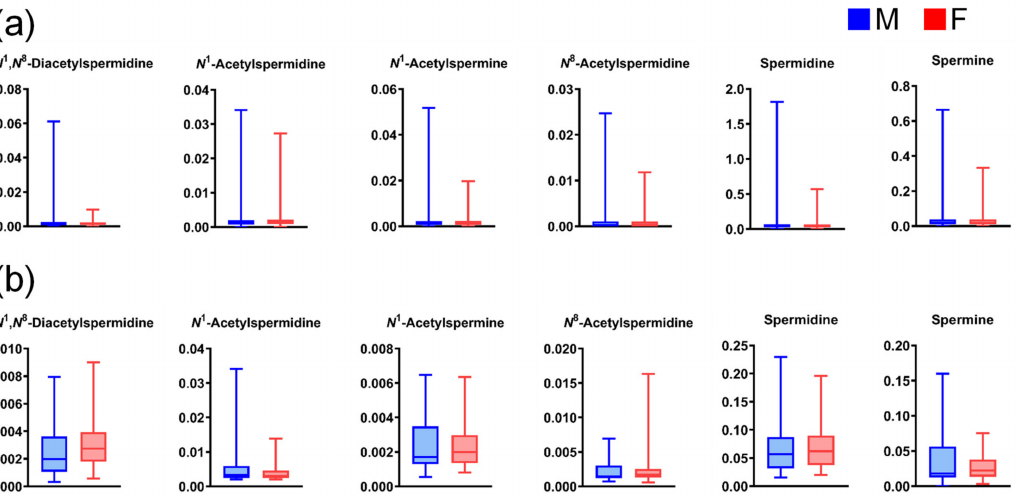
Figure A3. Differences in salivary polyamine concentrations between ( a ) healthy individual male (M) and female (F) participants ( n = 423 and 501, respectively) and ( b ) M and F patients with pancreatic diseases ( n = 27 and 40, respectively). Horizontal lines of box plots present 0, 25, 50, 75, and 100% of data. All comparisons show p > 0.05, using the Mann–Whitney U test.